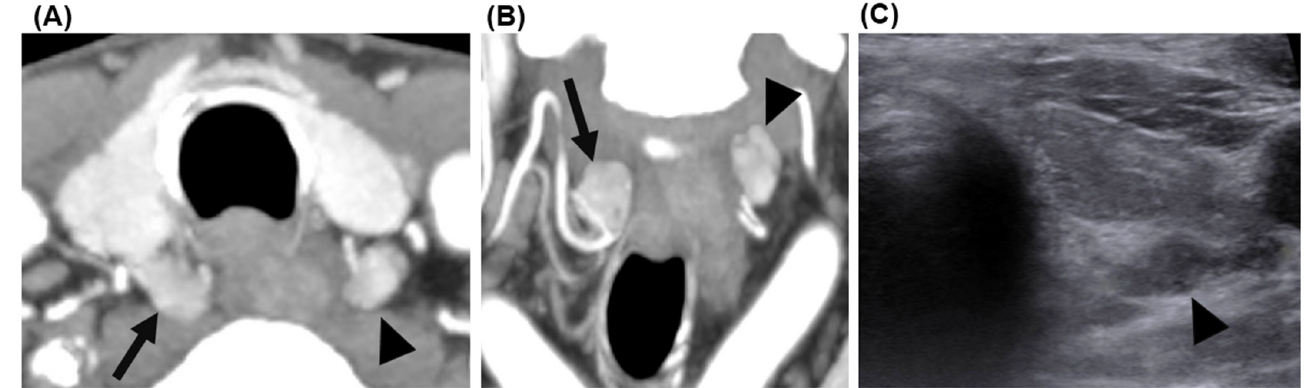
Figure 5. A 63-year-old man with secondary hyperparathyroidism. 4D-CT revealed right superior parathyroid hyperplasia (arrow) and left superior parathyroid hyperplasia (arrowhead) in axial view ( A ) and in coronal view ( B ). Ultrasound revealed left superior parathyroid hyperplasia (arrowhead) in axial view ( C ). The right superior parathyroid hyperplasia was not seen because it was behind the trachea.